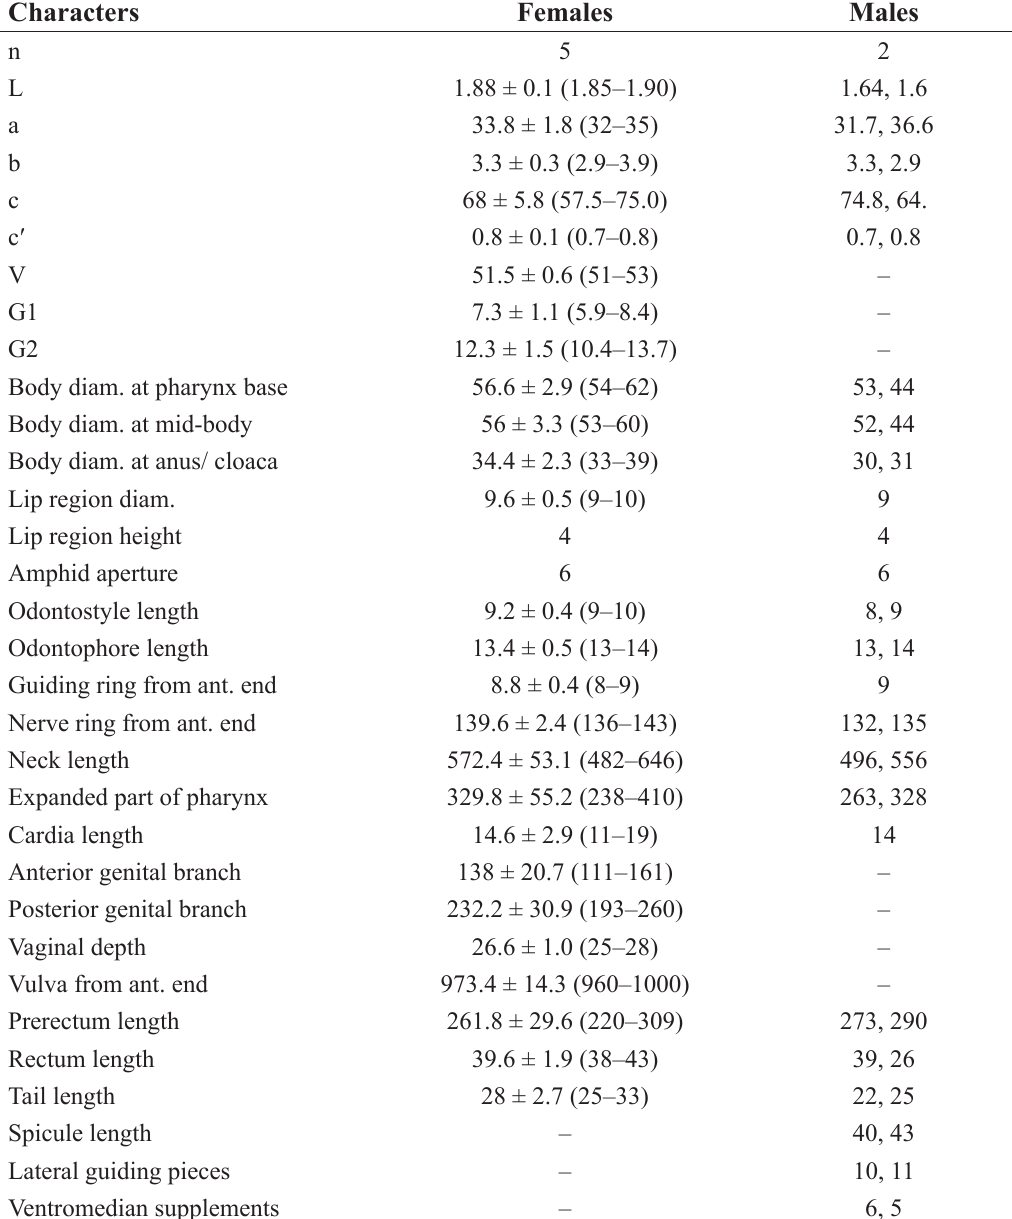
Table 2. Measurements of Axonchium saccatum Jairajpuri, 1964. All measurements in µm, except L in mm, and in the form: mean ± s.d. (range) for females, and measurements for each male (n = 2) separated by a